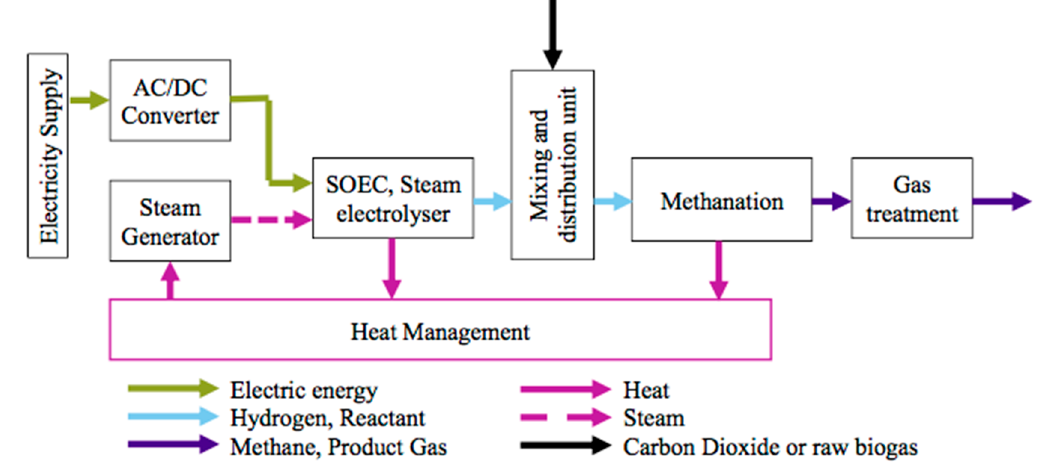
Figure 1. Schematic of diagram of Power to Methane with Solid Oxide Electrolysis